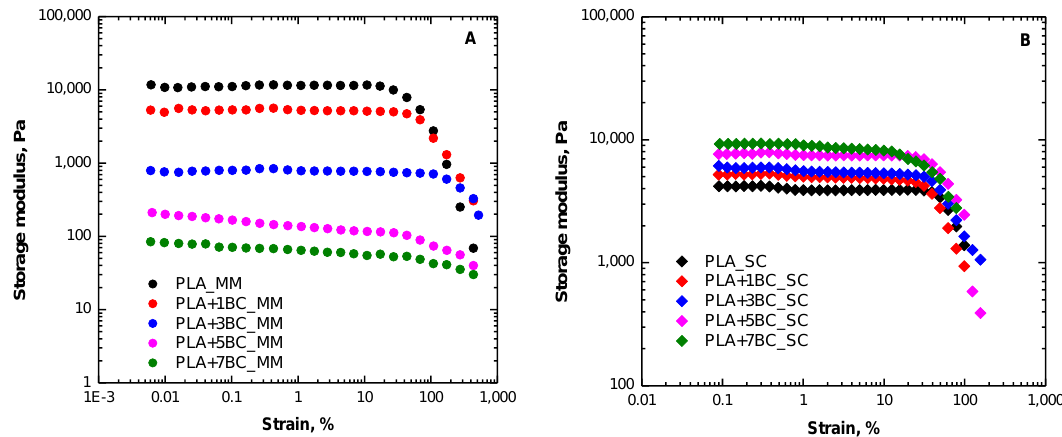
Figure 2. Results of large amplitude oscillatory shear (LAOS) tests for neat PLA and BC-containing composites obtained through melt mixing ( A ) and solvent casting ( B ).